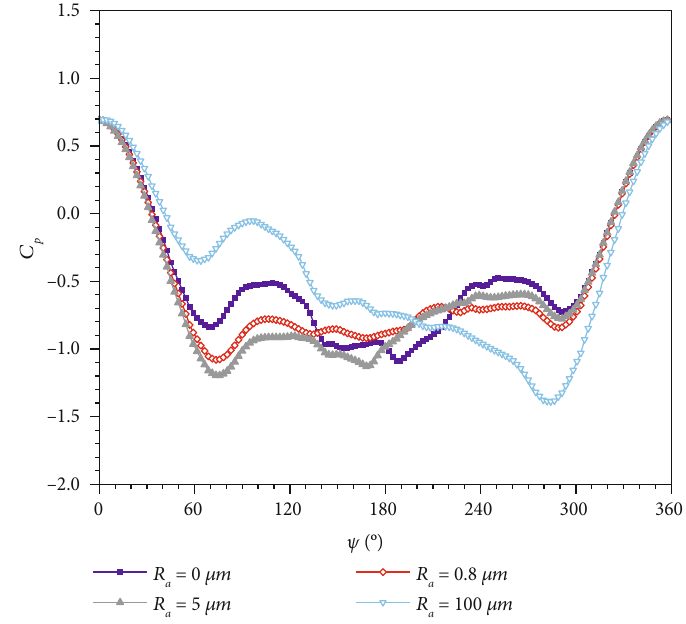
Figure 40: Pressure coe ffi cient distribution of di ff erent models at 8 D